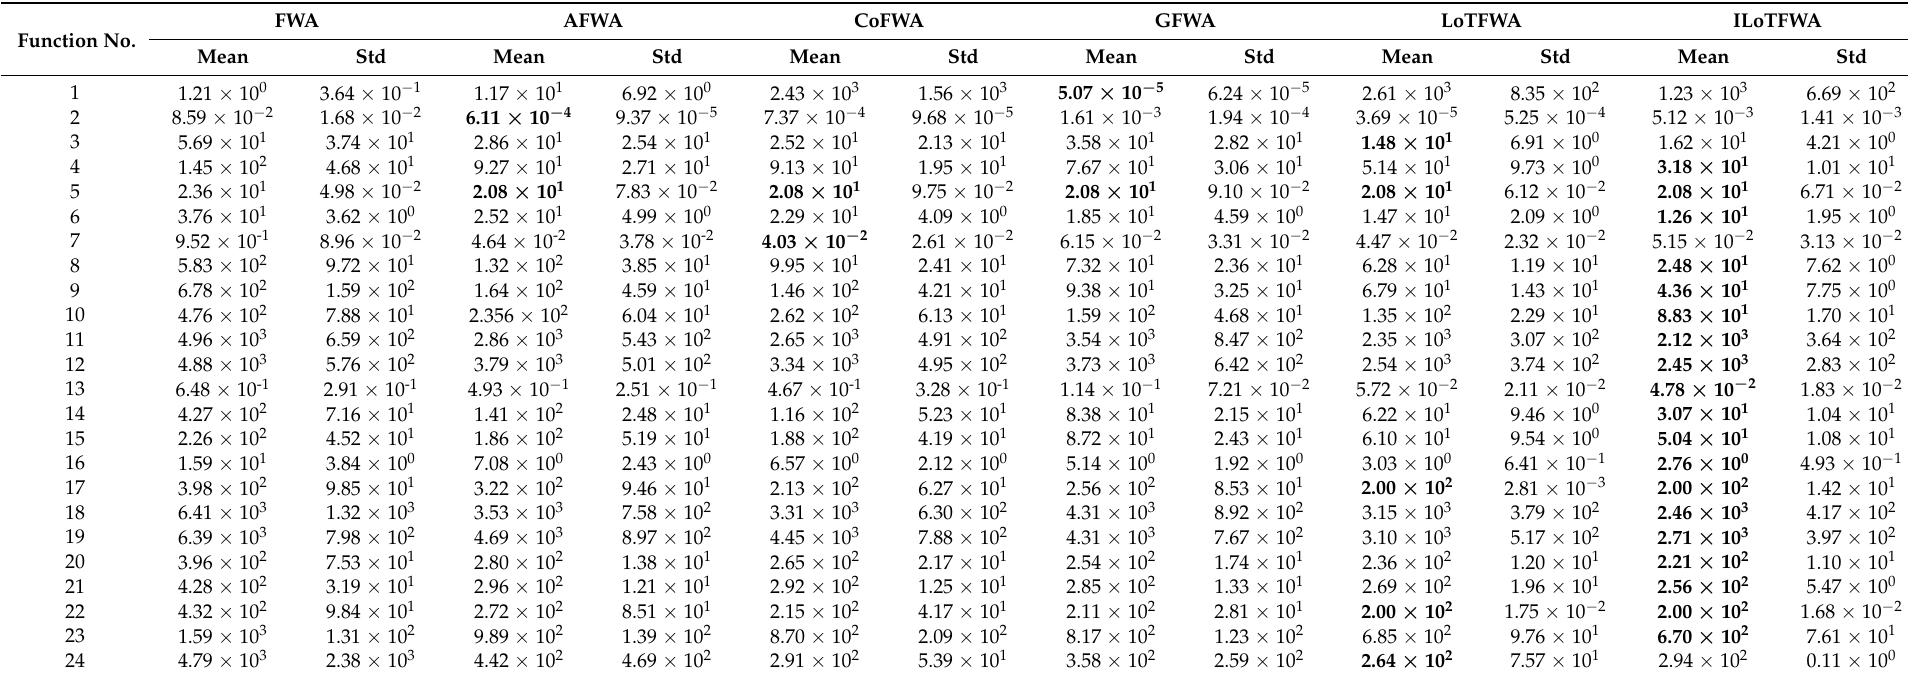
Table 2. Mean and standard deviation comparison results of ILoTFWA and other FWA